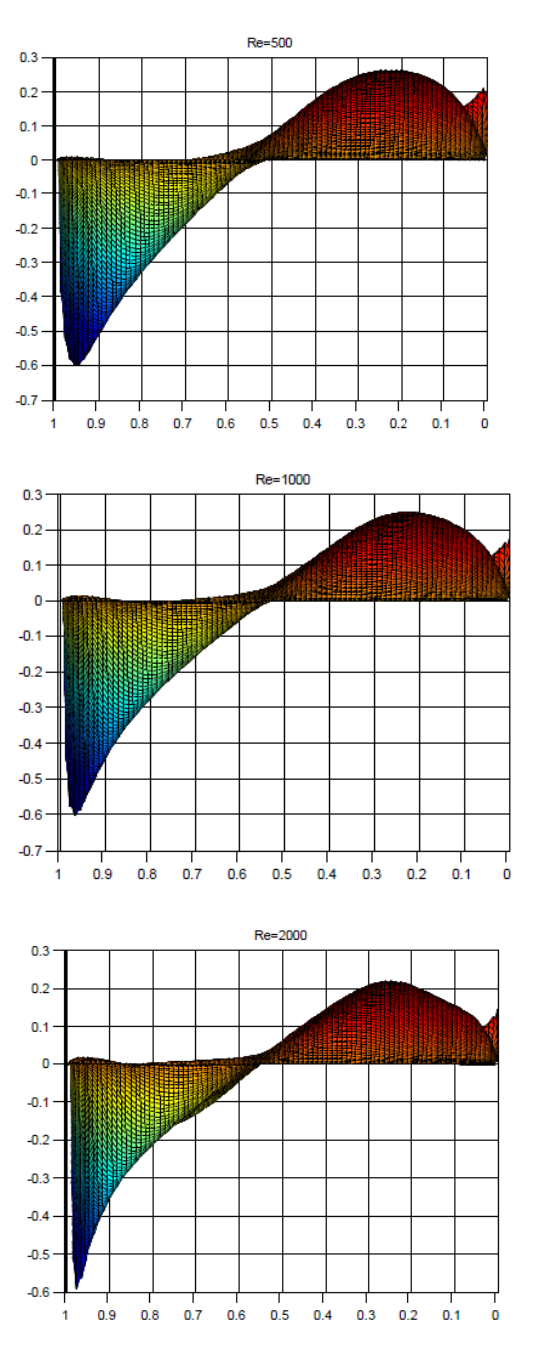
Figure 3. v- velocity at Re=500, Re=1000 and